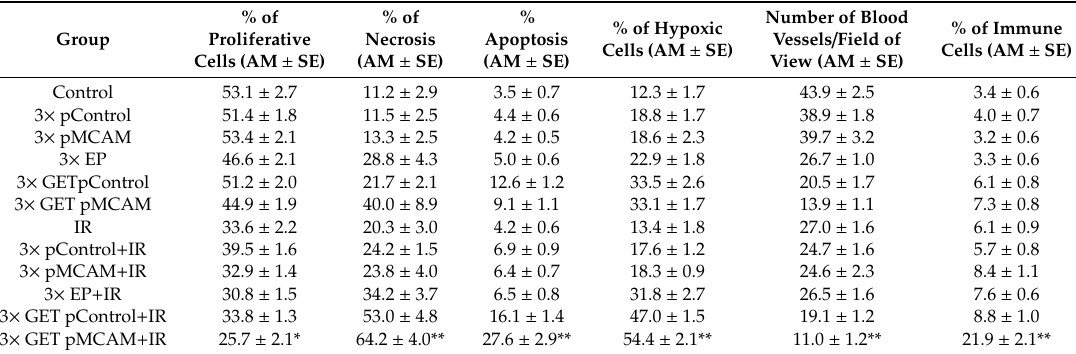
% of Hypoxic Cells (AM ± SE)